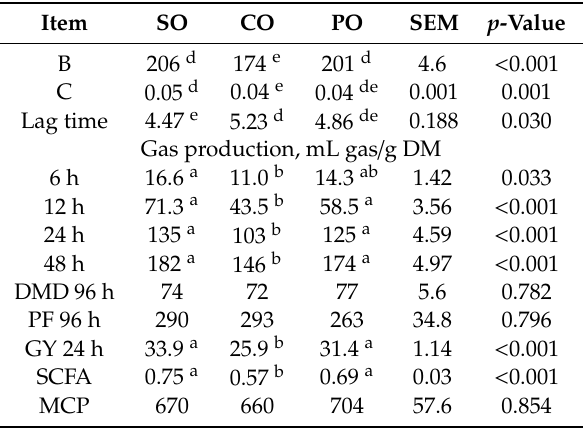
Table S1: in vitro rumen gas kinetics, cumulative gas production and rumen fermentation profile after 96 h of incubation as a ff ected by the ingredients used in goats with di ff erent calcium soaps